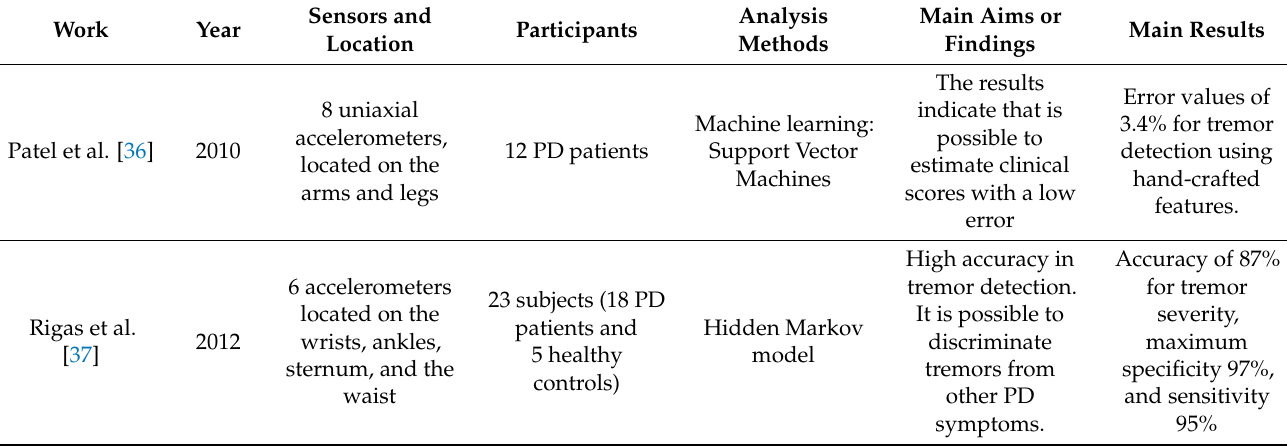
Table 1. Summary of highlighted research articles for tremor analysis using wearable